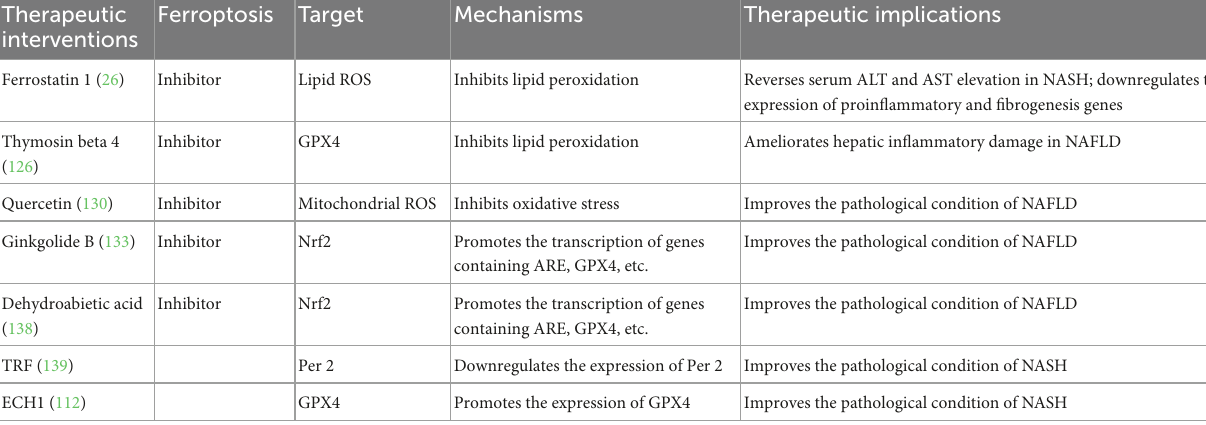
TABLE 1 Potential effective therapies targeting ferroptosis for NAFLD. Therapeutic Ferroptosis Target Mechanisms Therapeutic interventions